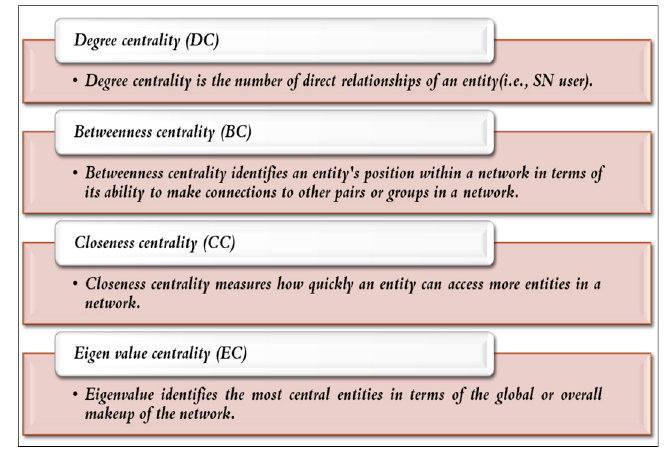
Figure 30. Description of the four centralities used in social network analysis (SNA).